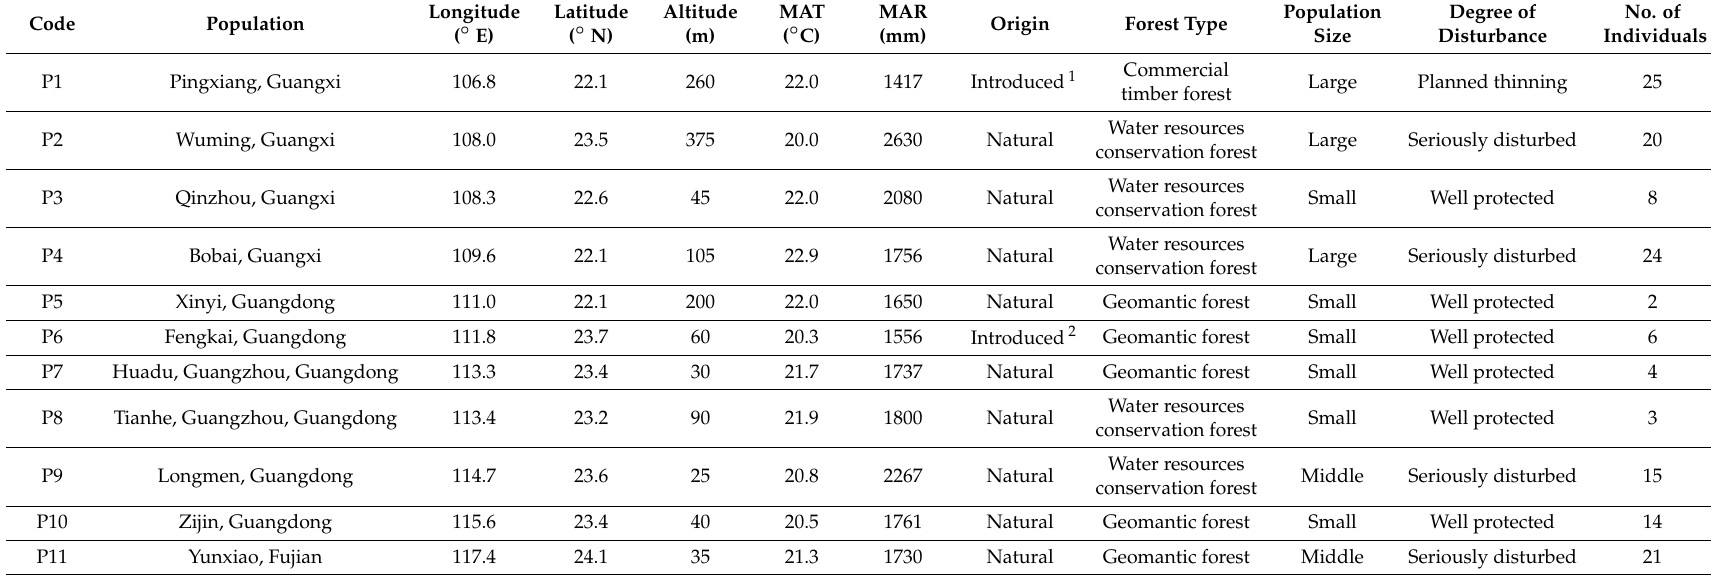
Table 1. Sampling sizes and general situation of 11 Erythrophleum fordii Oliv.